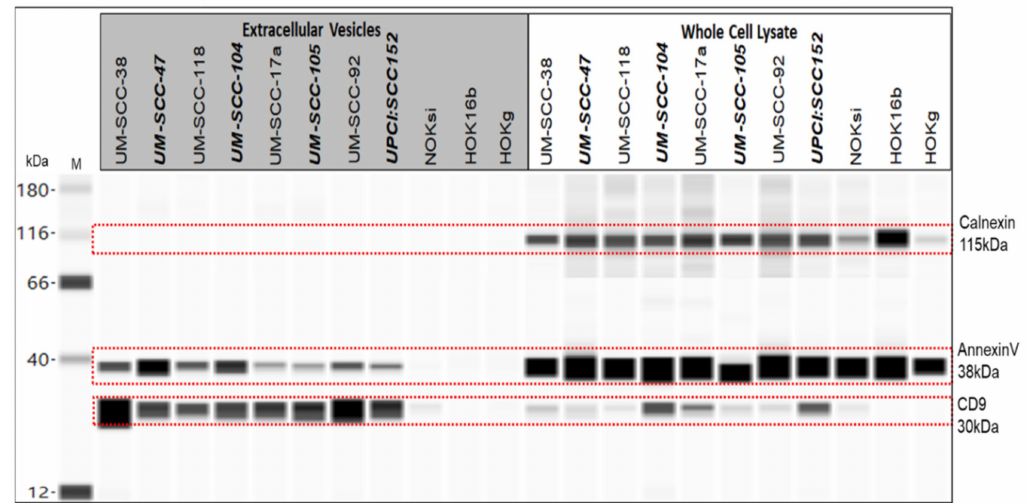
Figure 3. Wes protein analysis. Calnexin 1:50, 1 µ g/ µ L protein; annexinV 1:200, 0.25 µ g/ µ L protein; CD9 1:25, 1 µ g/ µ L protein. Bold italics: